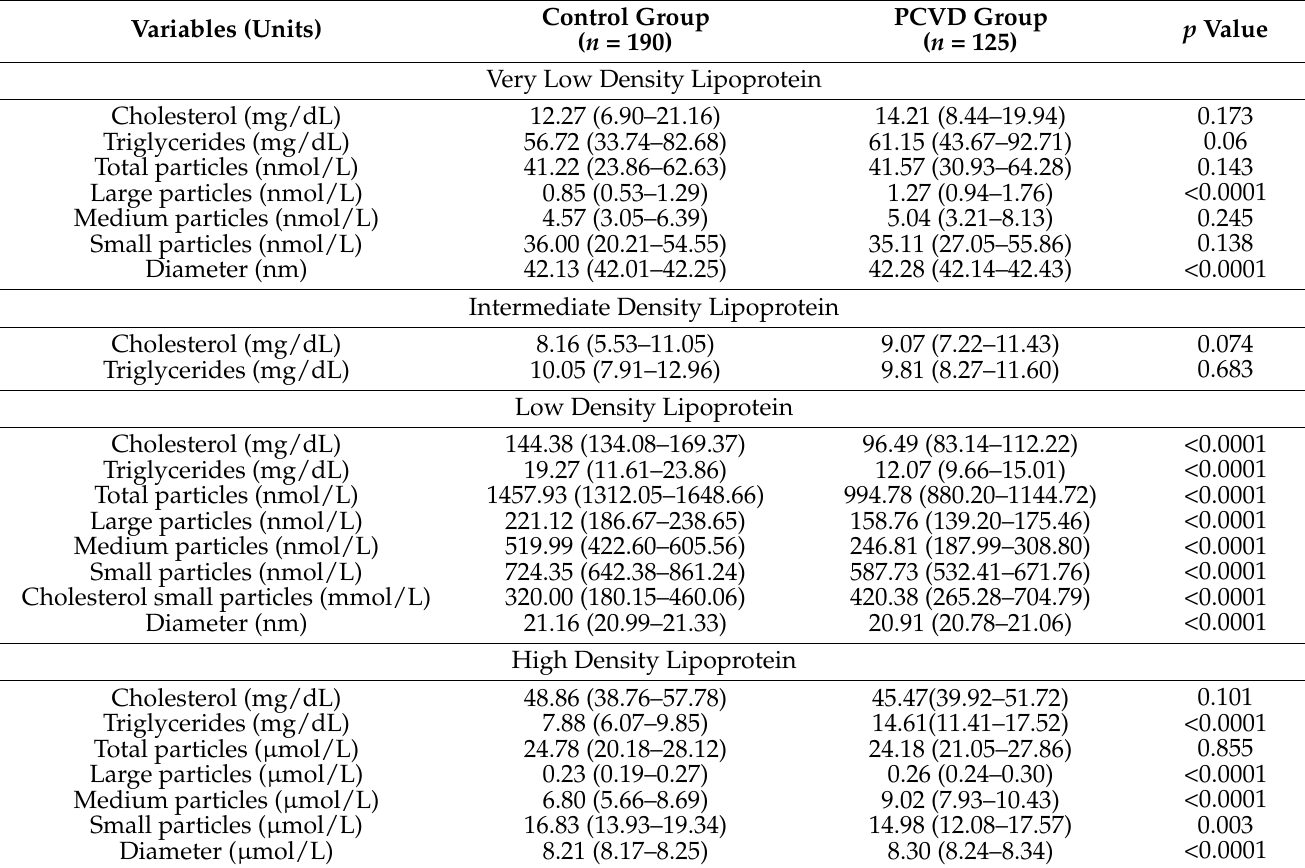
Table 2. Comparison between the advanced lipoprotein panels of the two